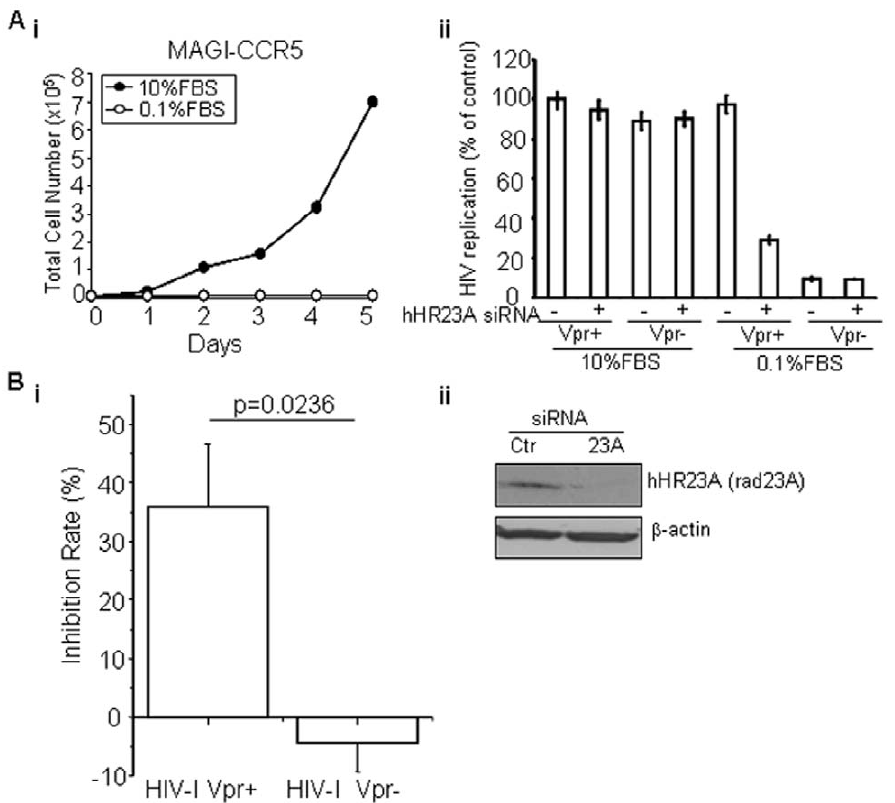
Figure 3. hHR23A is required for Vpr-mediated stimulation of HIV-1 replication in non-dividing MAGI-CCR5 cells and macrophages. A.i. Cell proliferation of MAGI-CCR5 cells in different FBS concentration. MAGI-CCR5 cells were plated at 7,000 cells/well in DMEM containing 10% or 0.1% of FBS. Cellular proliferation was measured over a period of 5 days. Cells in 0.1% FBS were viable over the experimental period, as they remained adherent to plates. ii. Depletion of hHR23A significantly reduces viral replication in non-dividing MAGI cells in a Vpr-dependent manner. MAGI-CCR5 cells were transfected with hHR23A-targeting ( + ) or control ( 2 ) siRNA, plated in DMEM with 10% or 0.1% FBS, and infected with HIV-1 Ada Vpr( + ) or Vpr( 2 ) 24 hrs after hHR23A knockdown. Viral replication was evaluated 48 hrs after infection by staining; blue cells were counted as infected. Results are presented as percent of control, i.e., the number of blue cells in cultures transfected control siRNA and infected with Vpr-positive HIV-1 and show average 6 SE of quadruplicate determinations. B. Vpr-dependent HIV-1 viral replication in macrophages is mediated through hHR23A. i. Monocyte- derived macrophages pretreated with hHR23A siRNA or control (Ctr) siRNA were infected with HIV-1 Ada (Vpr + ) or (Vpr 2 ) viruses. Cells were collected 72 hrs p.i. and viral replication was determined by measuring p24. Results are presented as inhibition of HIV-1 replication in cells treated with hHR23A siRNA relative to cells treated with control siRNA, and show mean 6 SE of three independent experiments with cells from different donors, each performed in triplicate. Statistical analysis was performed using Student’s t-test, and p value is shown. ii. Monocyte-derived macrophages were transfected with hHR23A siRNA or control siRNA. Cells were collected 72 hrs p.t. and subjected to Western blot analysis using anti-Rad23A and anti- b - actin